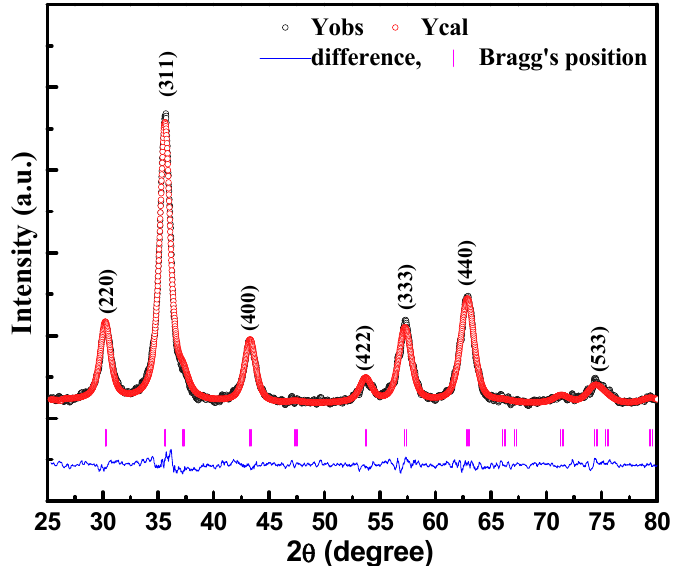
Figure 1. X-ray diffraction pattern of CeFe 2 O 4 nanostructures measured at room temperature.